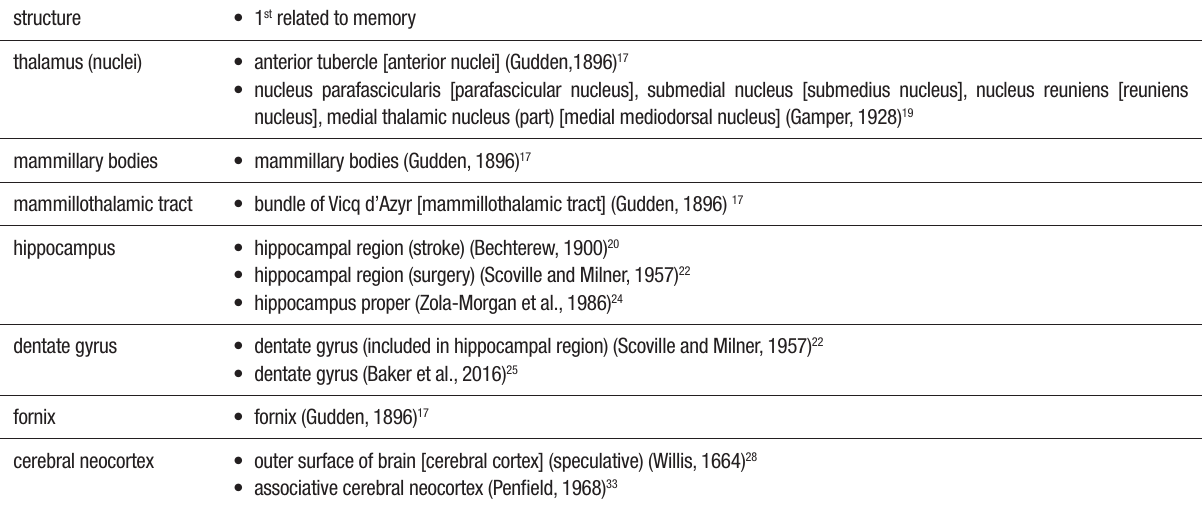
Table. Anatomical structures first related to memory (current names in square brackets).